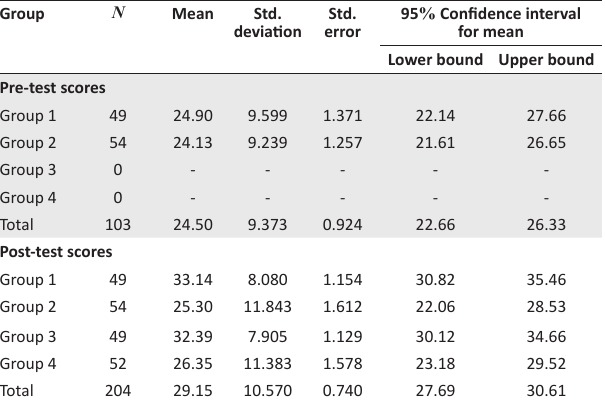
TABLE 2: Descriptive statistics of the scores of the four groups.